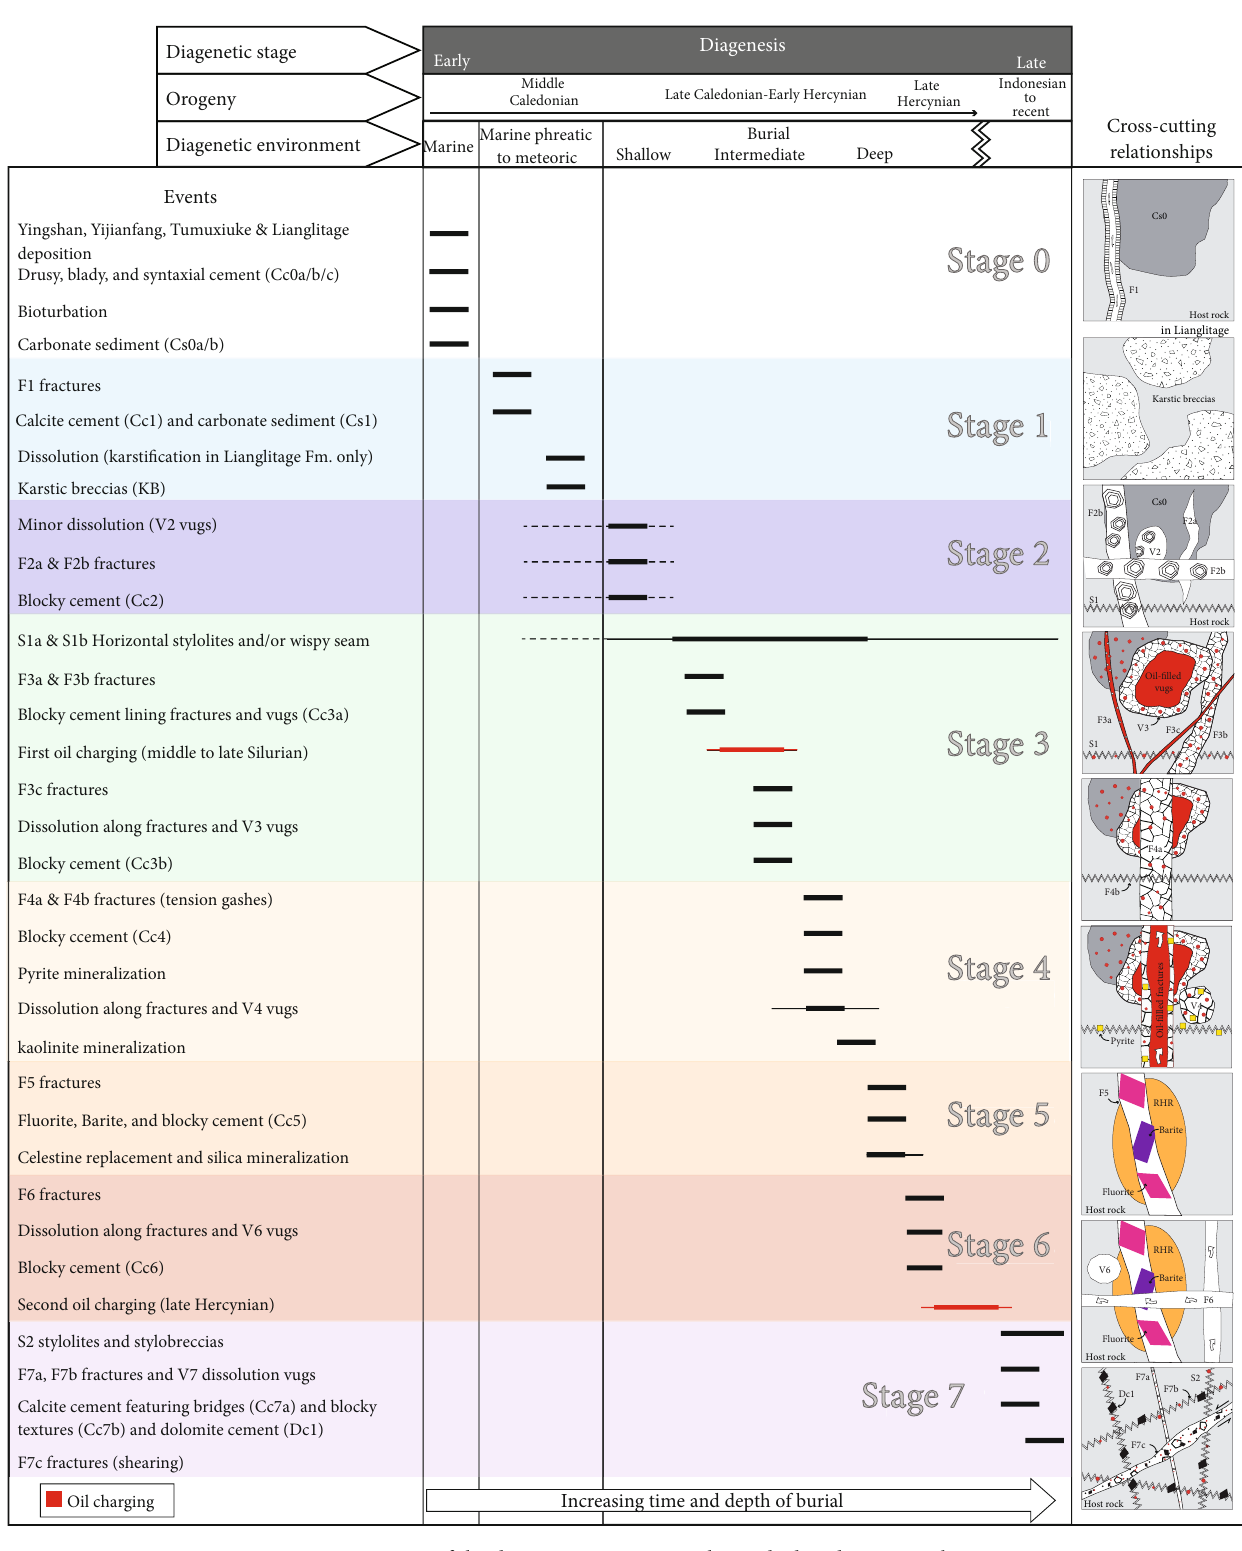
Figure 12: Summary of the diagenetic sequence in the studied Ordovician